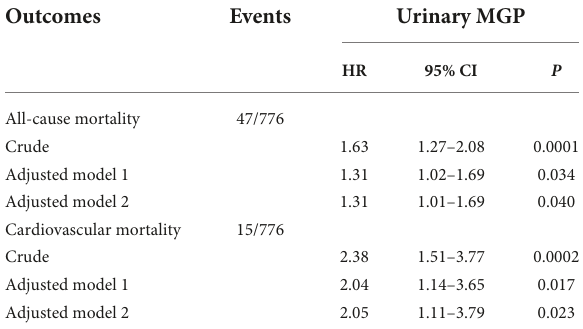
TABLE 2 Association of urinary matrix Gla protein (MGP) with all-cause mortality and cardiovascular